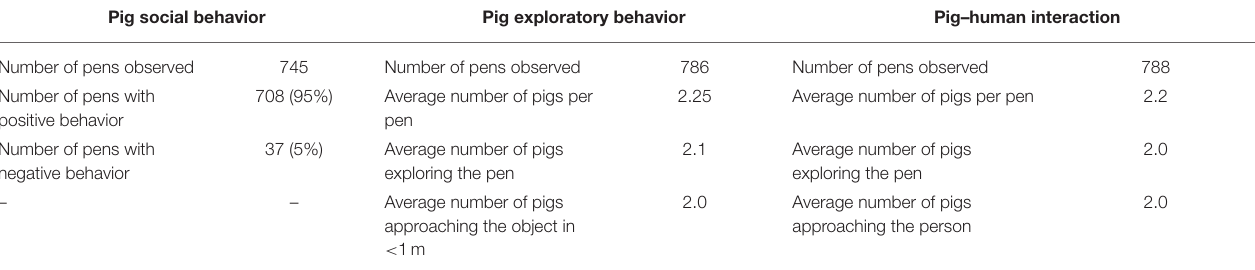
TABLE 8 | Patterns of pigs’ behavior in studied farms. Pig social behavior Pig exploratory